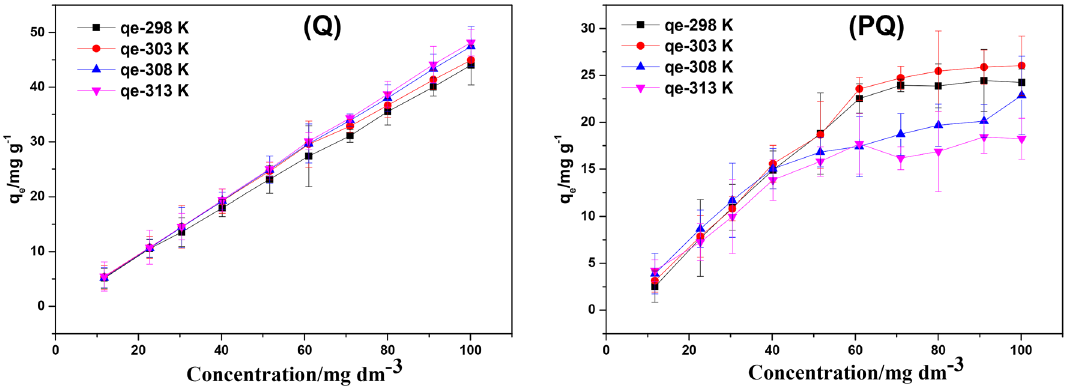
Figure 11. The effect of initial concentration on uptake of Cr(VI) by PQ and